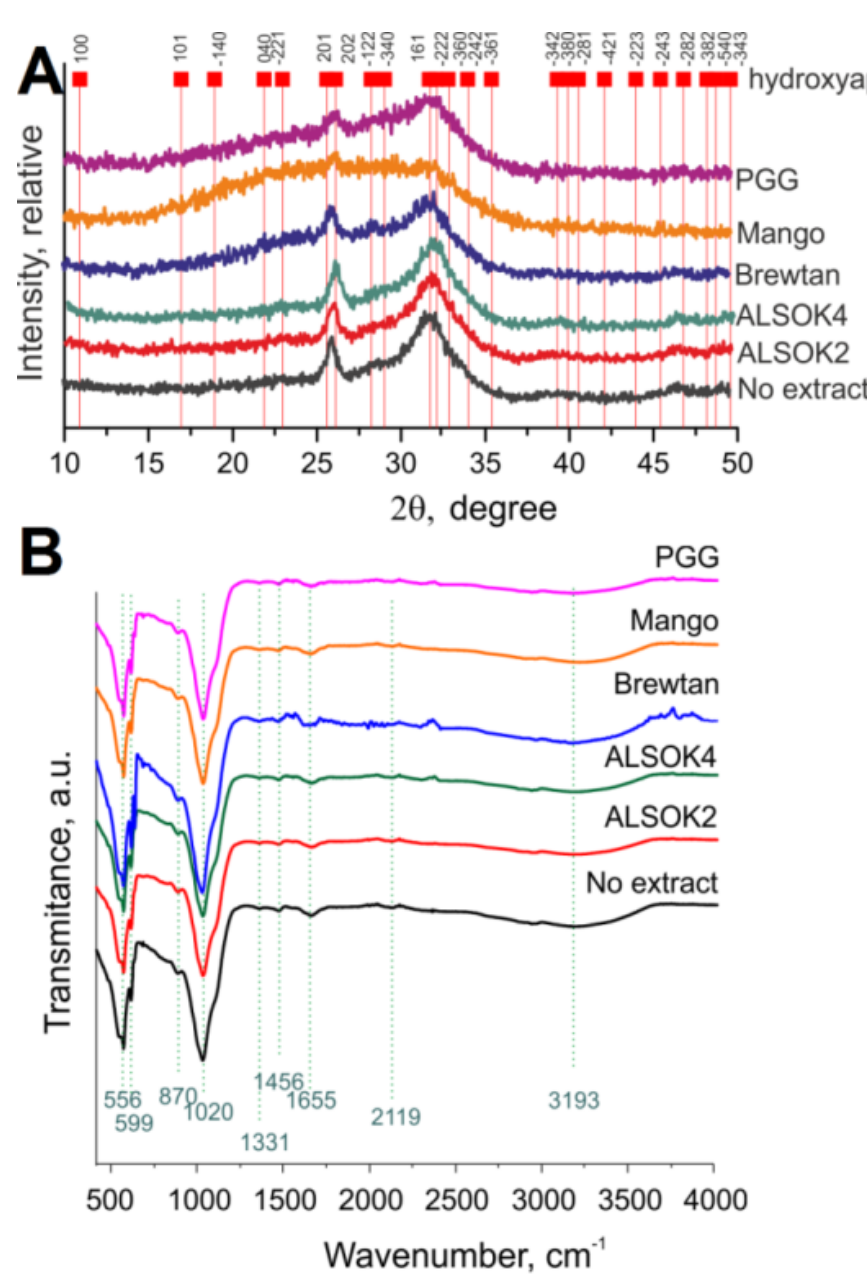
Figure 2. ( A ) X-ray diffraction (XRD) analysis of mineralized hydrogels containing different gallotannin preparations. Peaks indicated with red squares correspond to the hydroxyapatite phase. The Miller indices of each peak are highlighted on top. ( B ) FTIR analysis of mineralized hydrogels containing different gallotannin preparations.